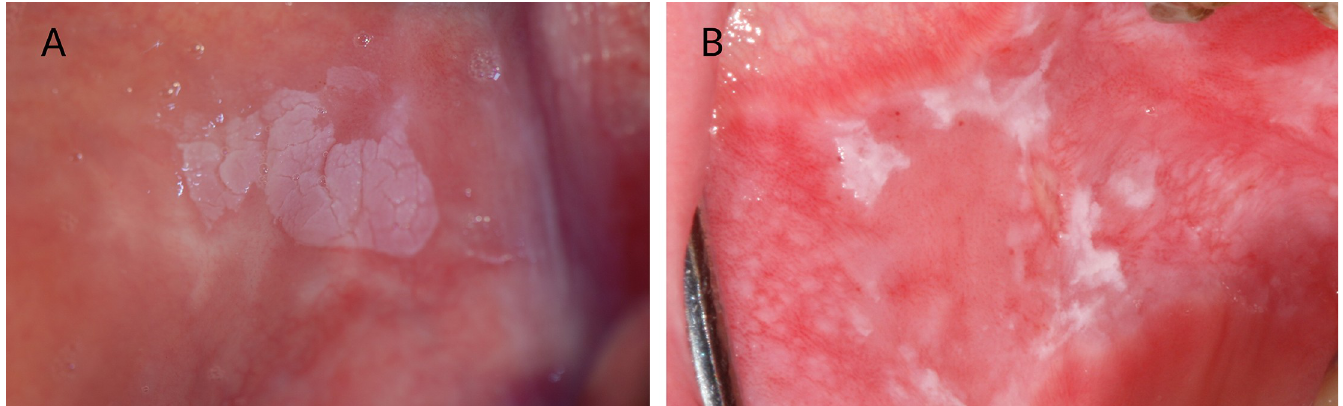
Fig 1. Clinical presentation of homogeneous leukoplakia. (A) and non-homogeneous leukoplakia (B) in the buccal